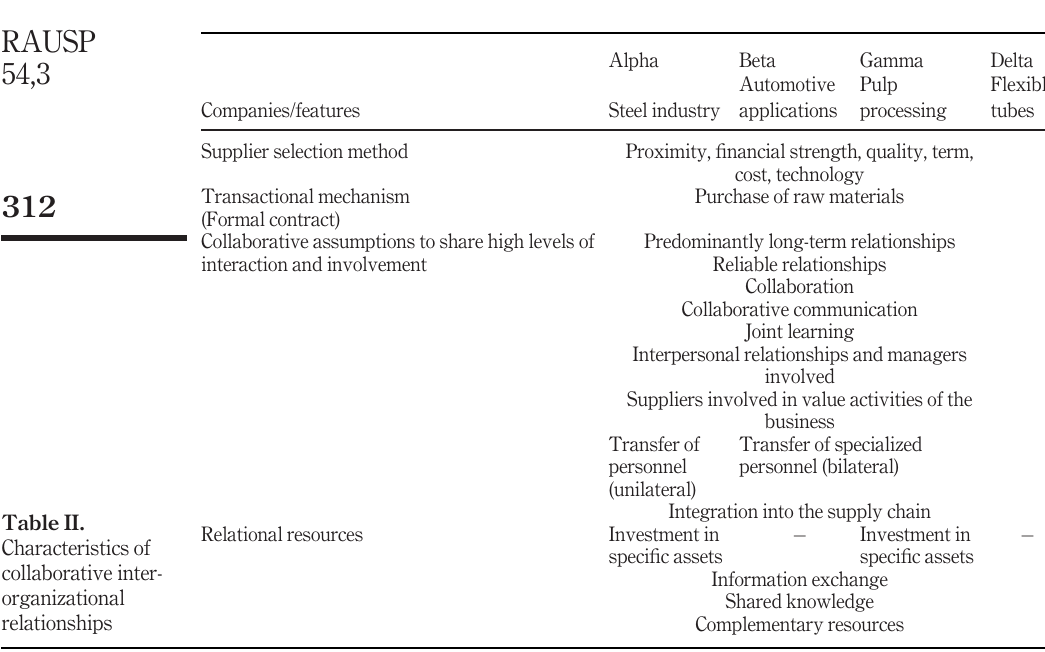
Table II. Characteristics of collaborative inter- organizational